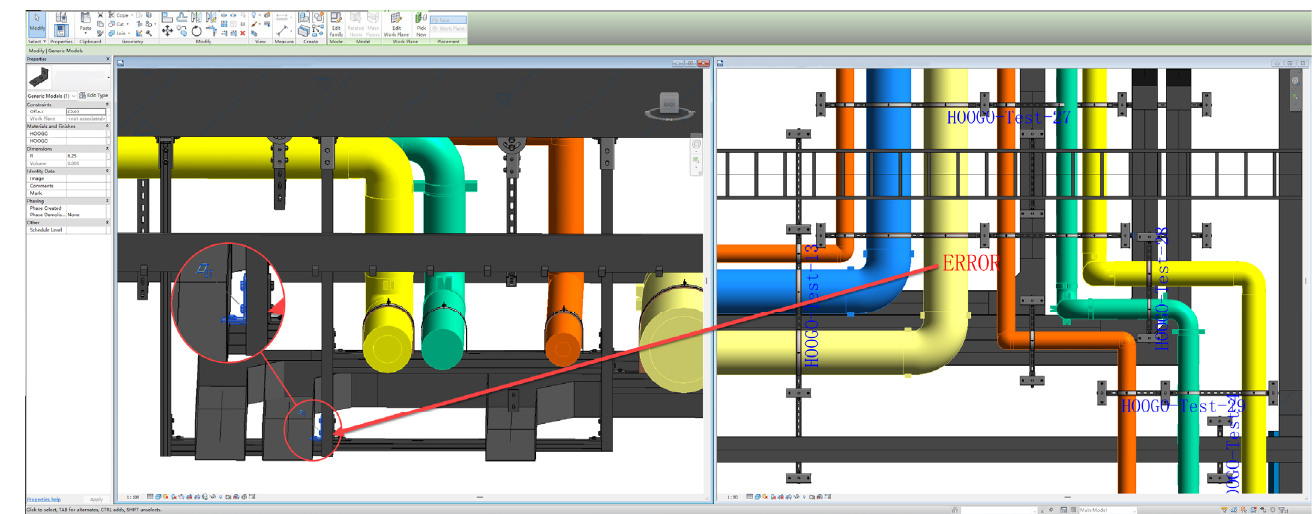
Figure 15. The result of the Component Constructability Checking.